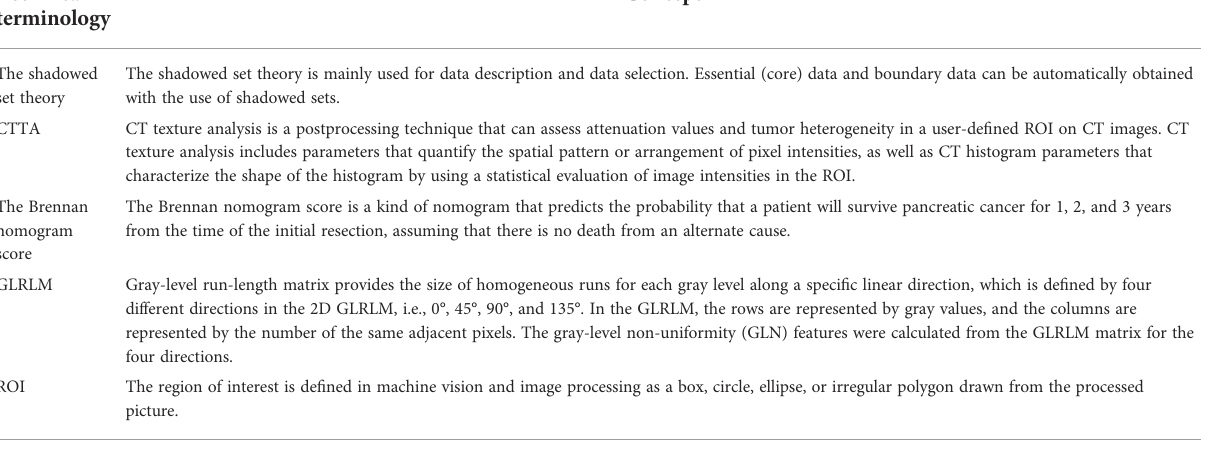
TABLE 2 Technical terminologies.